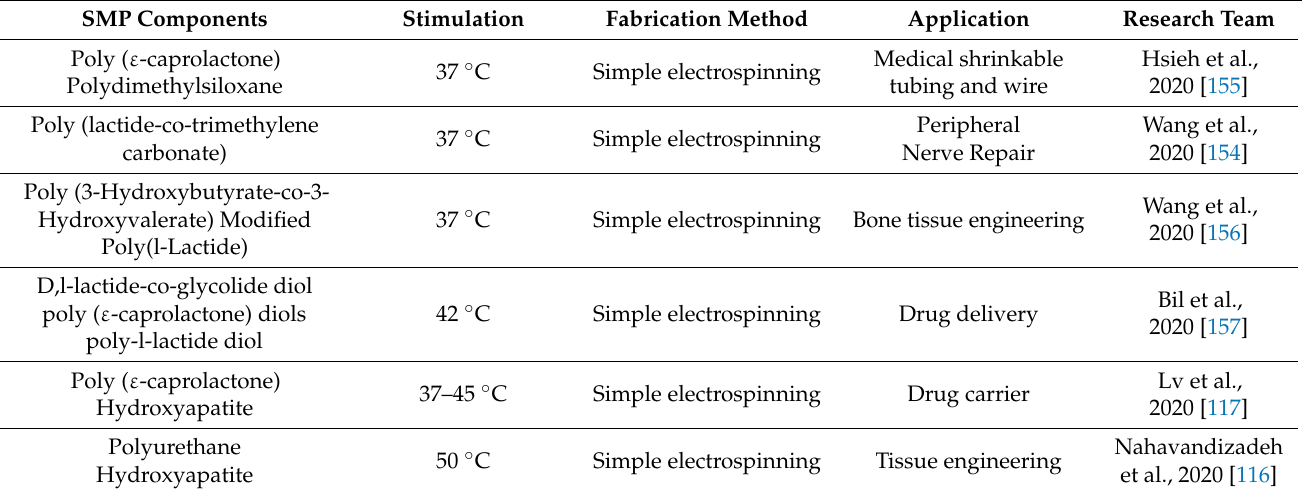
Table 1. A summary of recent works on SMP fibrous structures for biomedical applications. SMP